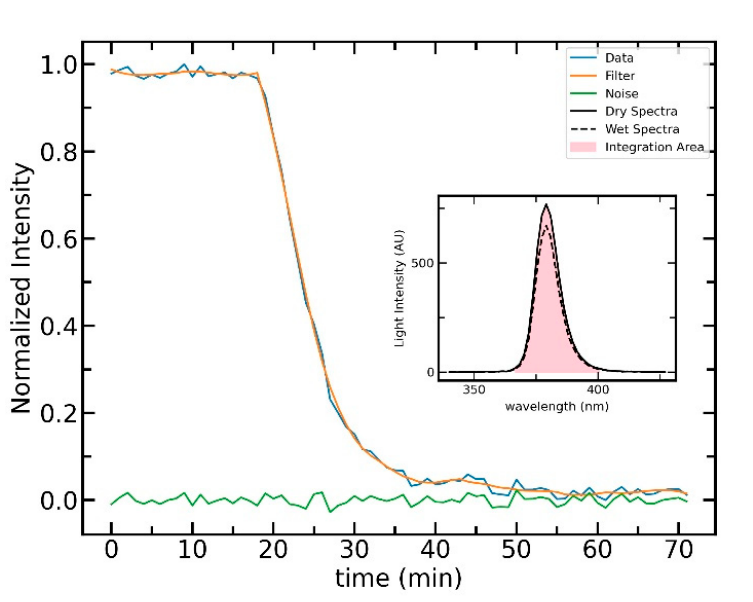
Figure 5. Scheme of the signal-to-noise computation of the signal (blue) with a Savitzky–Golay low-pass filter (orange) to separate the shape of the signal from its noise (green). The inset represents the wavelength from the UV-LED (370 nm) in black, with the integration area (pink) over which the data points are obtained.